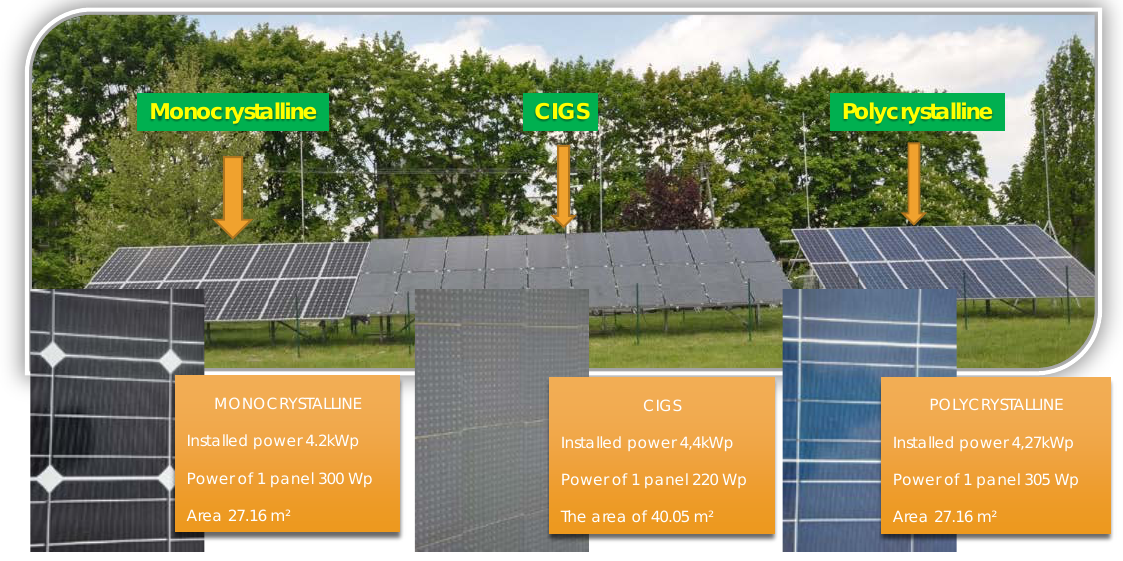
Figure 1. View of the photovoltaic power plant.